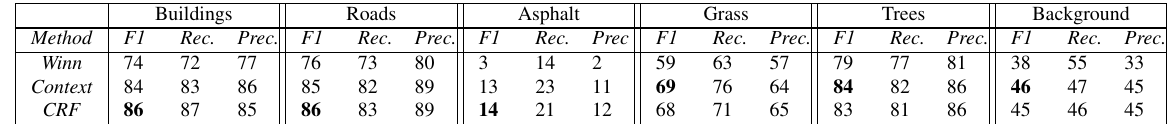
Table 1. Pixelwise performance for multi-label classification on the Vaihingen dataset. The overall accuracy for Winn, Context, and CRF are respectively: 73.69 , 82.35 , and 82.42 . All numbers are